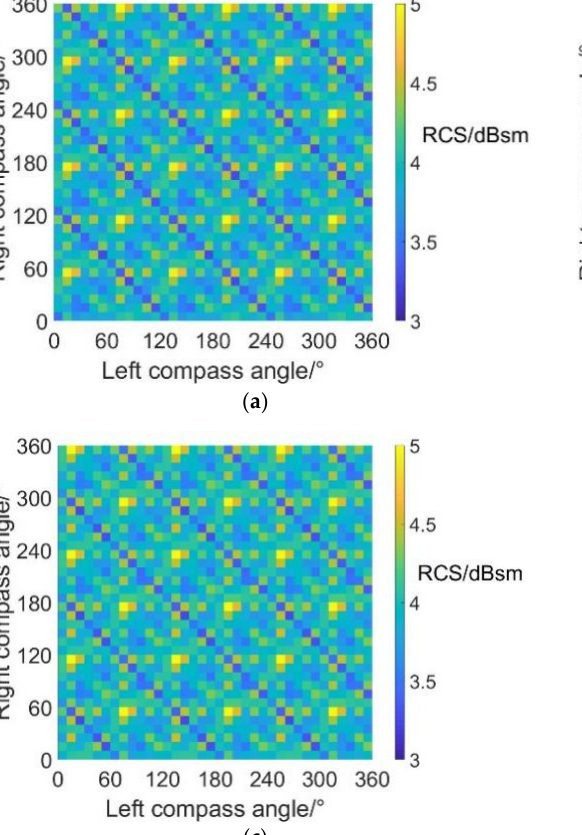
The points illustrated in Equation (41) are included in those illustrated in Equation (39), and the points illustrated in Equation (42) are included in those illustrated in Equa- tion (40), indicating that the noise SPL and average RCS can reach relatively low values at the same time when the scissors angle difference = 0° and 60°. When the scissors angle difference = 30° and 90°, noise SPL can reach relatively low values when the left and right compass angles satisfy the relationship of Equation (38). However, the average RCS values have a range of 4.0~4.2 dBsm, green bars in Figure 19b,d, not the relatively low RCS values. The maximum and minimum average RCS values in fixed-wing mode at an azimuth angle = 0° are listed in Table 14. By CSM phase modulation, the average RCS in fixed-wing mode at an azimuth angle = 0° can be reduced by 1.8 dBsm at most. Combined with Figure 13, it can be indicated that the situations of scissors angle difference = 0° and 60° might be better for RCS reduction as well as noise reduction.